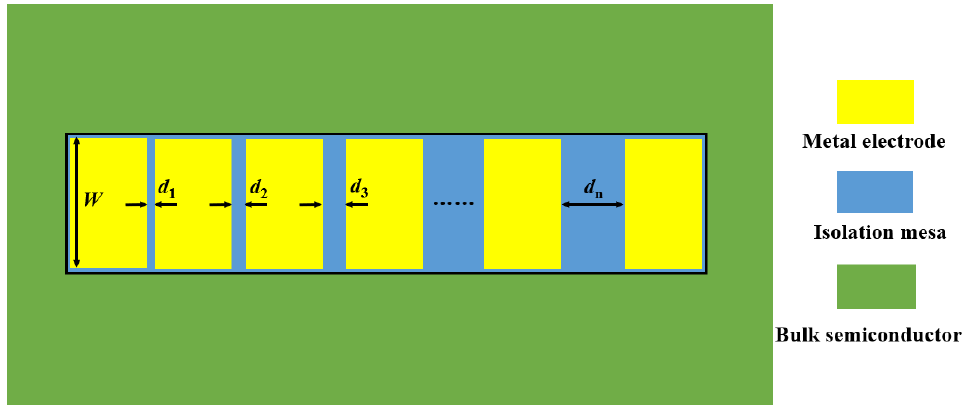
Figure 1. The schematic diagram of the rectangular electrode TLM structure. According to the TLM theory, the total resistance between each adjacent electrode in Figure 1 is given as: